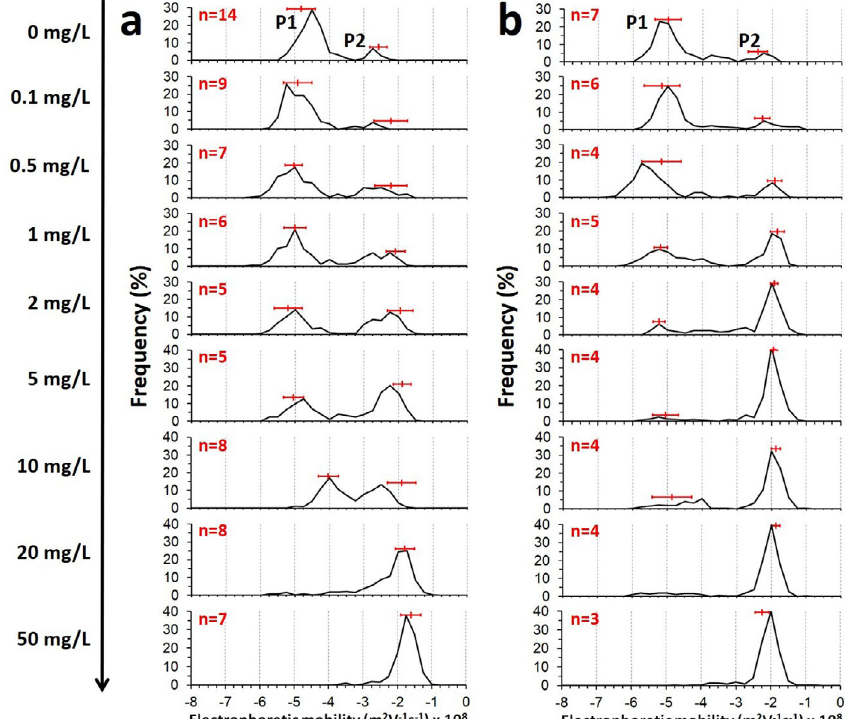
Fig. 3 Electrokinetic fi ngerprints of JW3606 (hep + ), JW3596 (hep − ), and secreted MVs as a function of TiO 2 NP concentration. Illustrative electropherograms for ( a ) JW3606 (hep + ) and ( b ) JW3596 (hep − ) suspensions after 20 h incubation with TiO 2 NPs at various concentrations (indicated). Horizontal red bars correspond to the position of the maxima (mean values ± standard deviations) derived from the measurement of n (indicated) electrophoretic mobility distributions for the suspensions prepared from different cell cultures or colonies, with three replicates for each measurement. The reported illustrative mobility distributions are averaged over three replicates. Analysis indicates that the number of detected electrophoretic trajectories decreases by 16% and 20% in the 1 – 10 mg/L and 1 – 2 mg/L TiO 2 NP concentration regimes (analysis on 1:50 diluted JW3606 (hep + ) − TiO 2 NP and JW3596 (hep − ) − TiO 2 NP samples, respectively), which features signi fi cant P1 particle sedimentation under these conditions. A 61 − 70% increase in the number of trajectories is further observed in 1:50 diluted JW3606 (hep + ) − TiO − ) − TiO 2 NP and JW3596 (hep 2 NP samples, respectively, on further increasing the TiO 2 NP concentrations to 50 mg/L due to the released membrane material as a consequence of the mode of action of the TiO 2 NPs. See text for